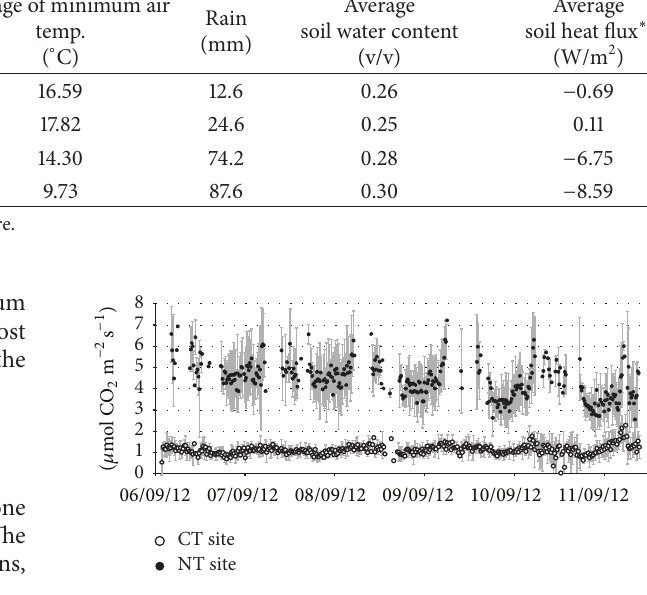
Figure 3: Six consecutive days of soil CO 2 flux measurements in the two experimental sites. Each point represents the average of the fluxes measured by all the chambers of the SASSFLUX system at each site (3 chambers at NT site and 4 chambers at CT site) in a 15 min period. Vertical bars indicate the standard deviation of the chambers measurements in each 15min period (CT = conventional tillage site; NT = no-tillage site). Points without vertical bars refer to 15 min periods in which only one chamber was